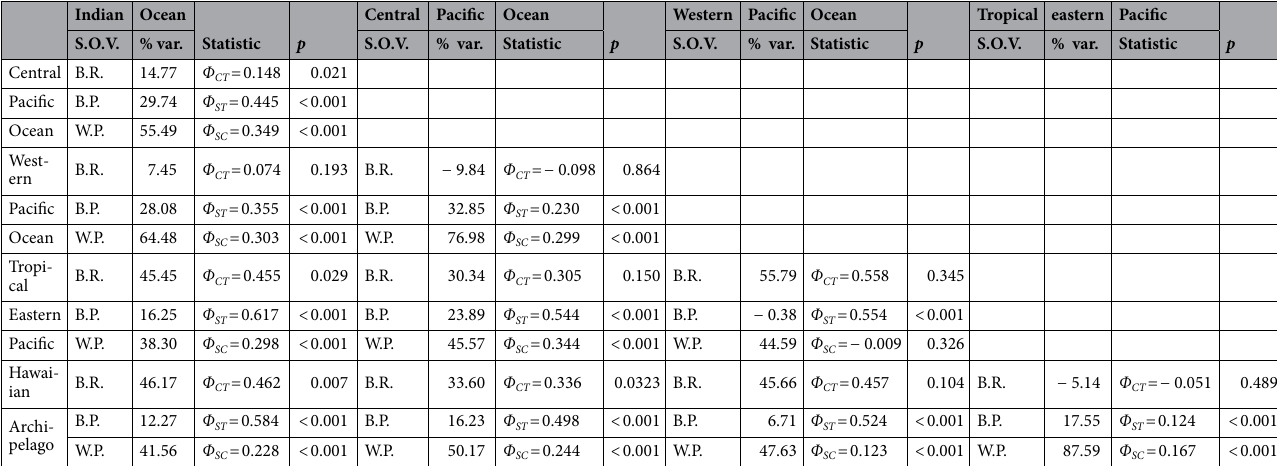
Table 4. Between region pairwise AMOVA based on mtDNA Tamura and Nei 31 distances in Echinothrix calamaris clade 1. S.O.V. source of variation, B.R. between regions, B.P. between populations within regions, W.P. within populations, % var . percentage of variation. n.b. Tropical eastern Pacific = Clipperton